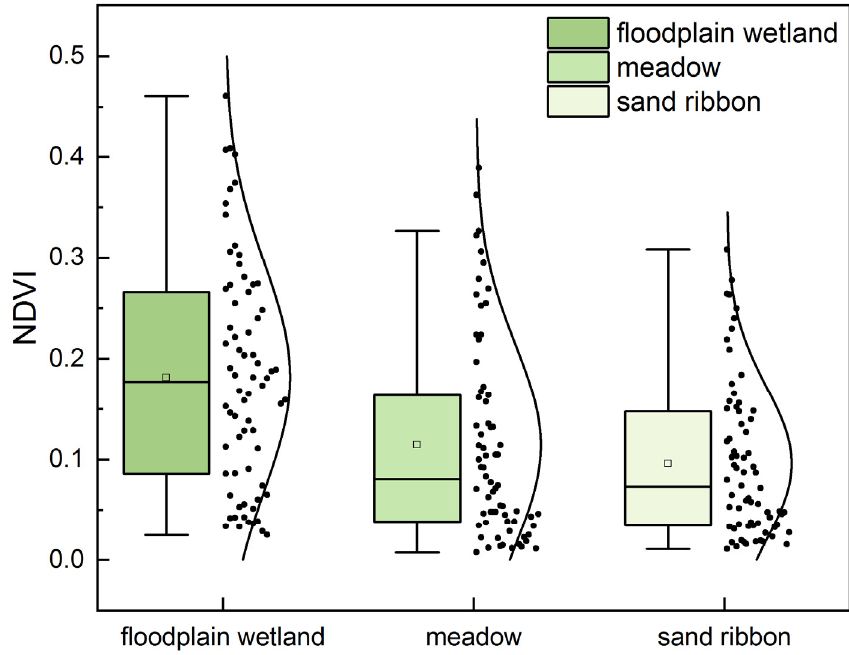
Figure 3. Statistical plots of NDVI for each ecosystem. The horizontal line in the boxplot is the median, and the hollow point is the mean. The black point on the right is each of the 70 images’ mean value of NDVI, and the curve is the distribution curve.